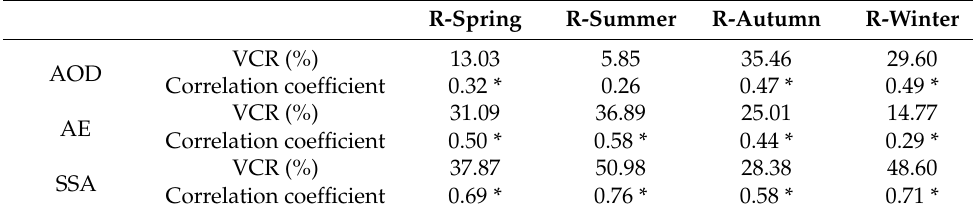
Table 3. Variance contribution rate (VCR) and correlation coefficient of the residual